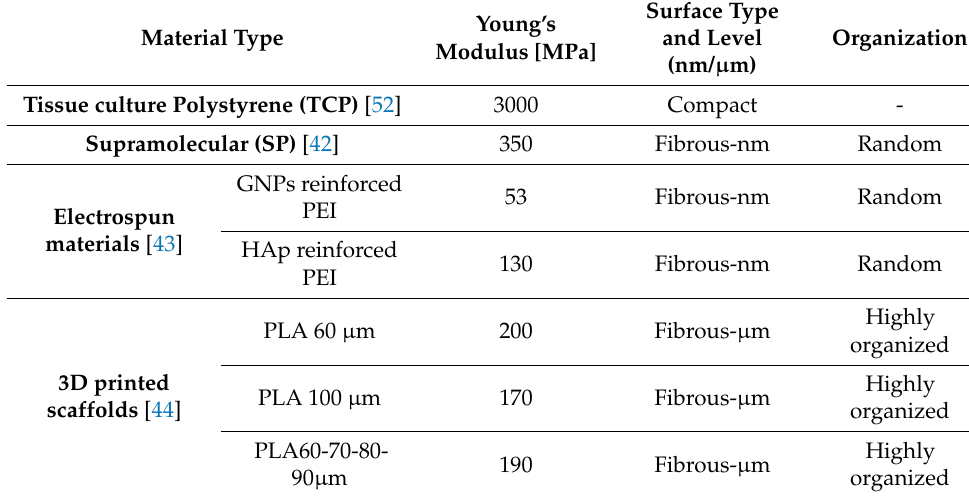
Table 1. Bulk and surface properties of plastic